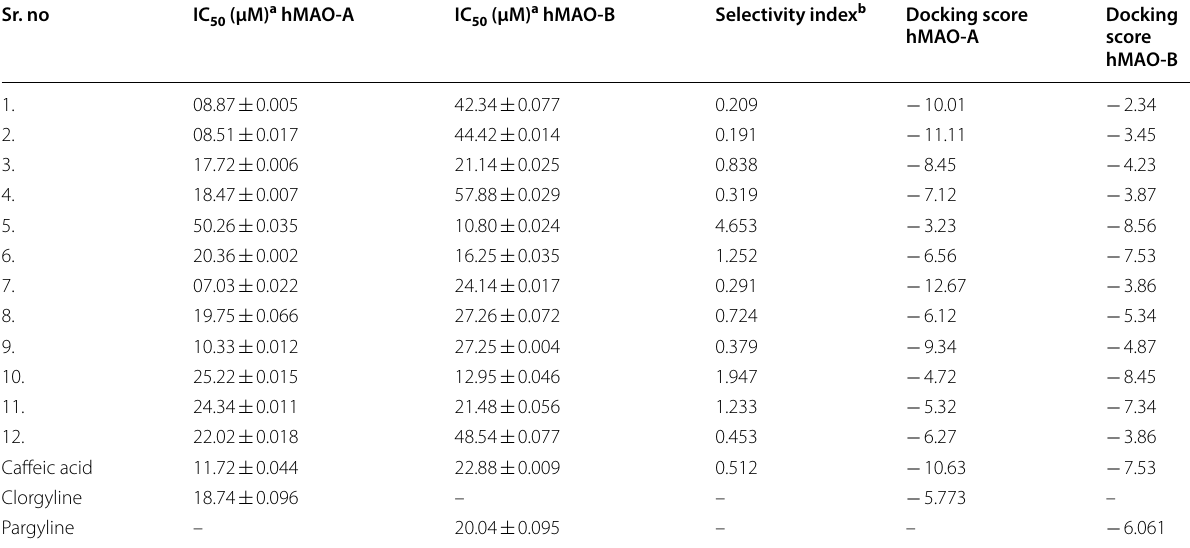
a Values related for the evaluated compound absorption which provide 50% inhibition of MAO-A and MAO-B, action, and are the mean SEM; statistical significance: p < 0.05 against the equivalent IC 50 values achieved against MAO-A and MAO-B, as identified through ANOVA/Dunnett’s